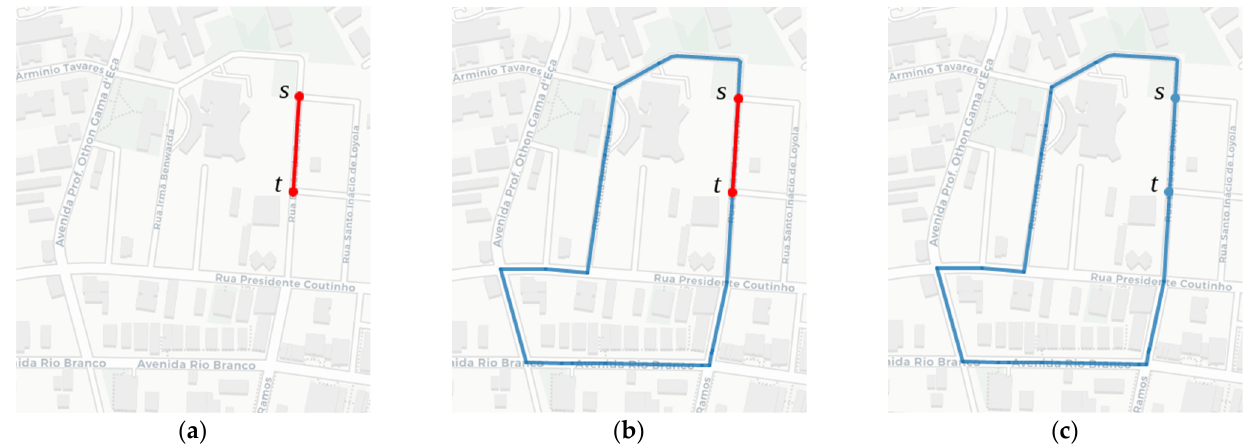
Figure 2. An illustration of the hot spot patrol route creation process using HotStar, commencing at ( a ) a hot segment ( s , t ), ( b ) creating a path p that starts at point s , and that ( c ) finishes at point t with the inclusion of the hot segment ( s , t ) in path p .